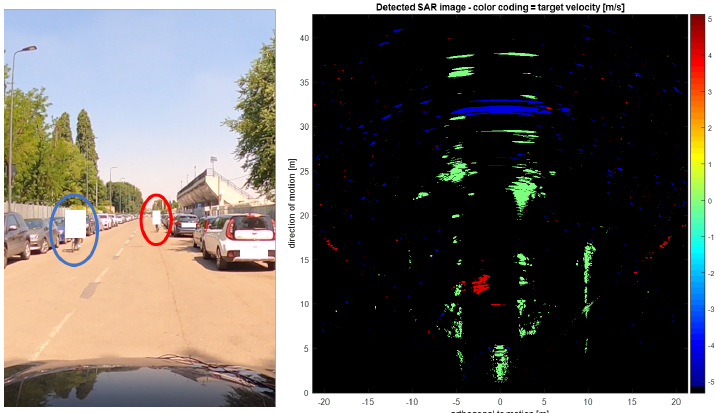
Figure 14. SAR imaging of moving target in an open road (forward-looking configuration): ( left ) camera image of the acquired scenario ( right ) RGB color-coded SAR image with the static scene (in green) and the detected moving targets (red and blue). In the red circle in the camera image, a cyclist moving in the direction of the ego-vehicle. In the blue circle, a cyclist moving in the opposite direction.